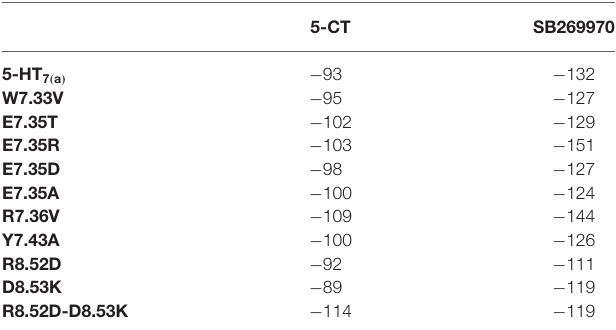
TABLE 1 | MolDock score (a.u.) from docking analysis of wild type and mutant receptors with 5-CT and SB269970